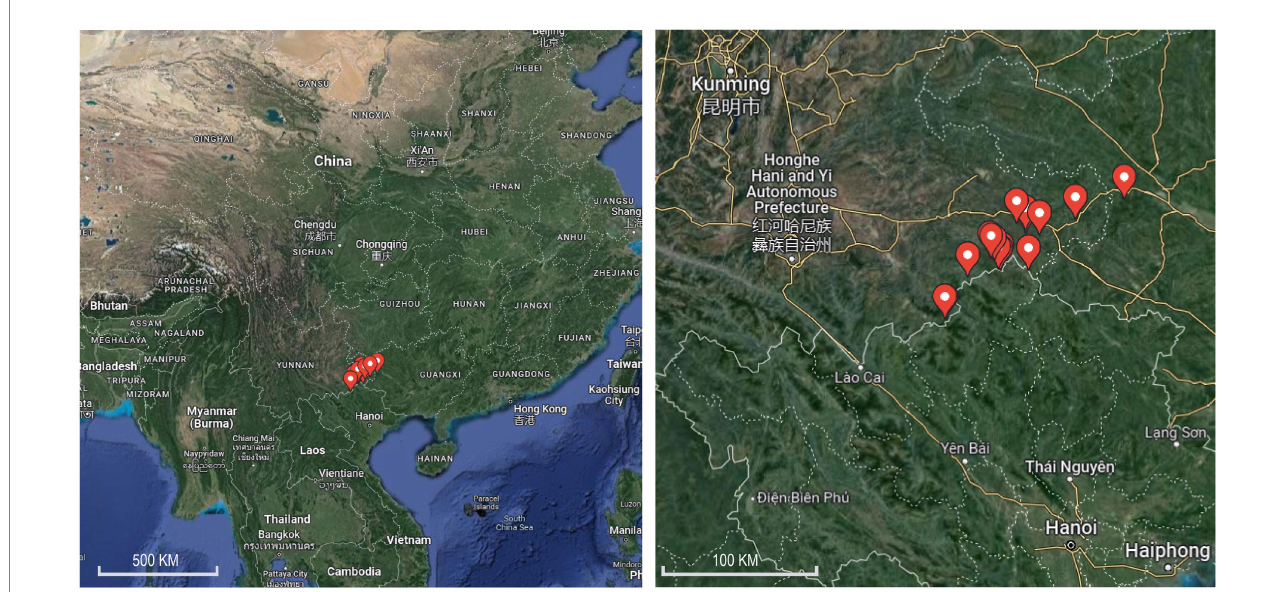
FIGURE 1 Map of mosquito collection sites along the Sino–Vietnam border in Yunnan Province, in 2020 and